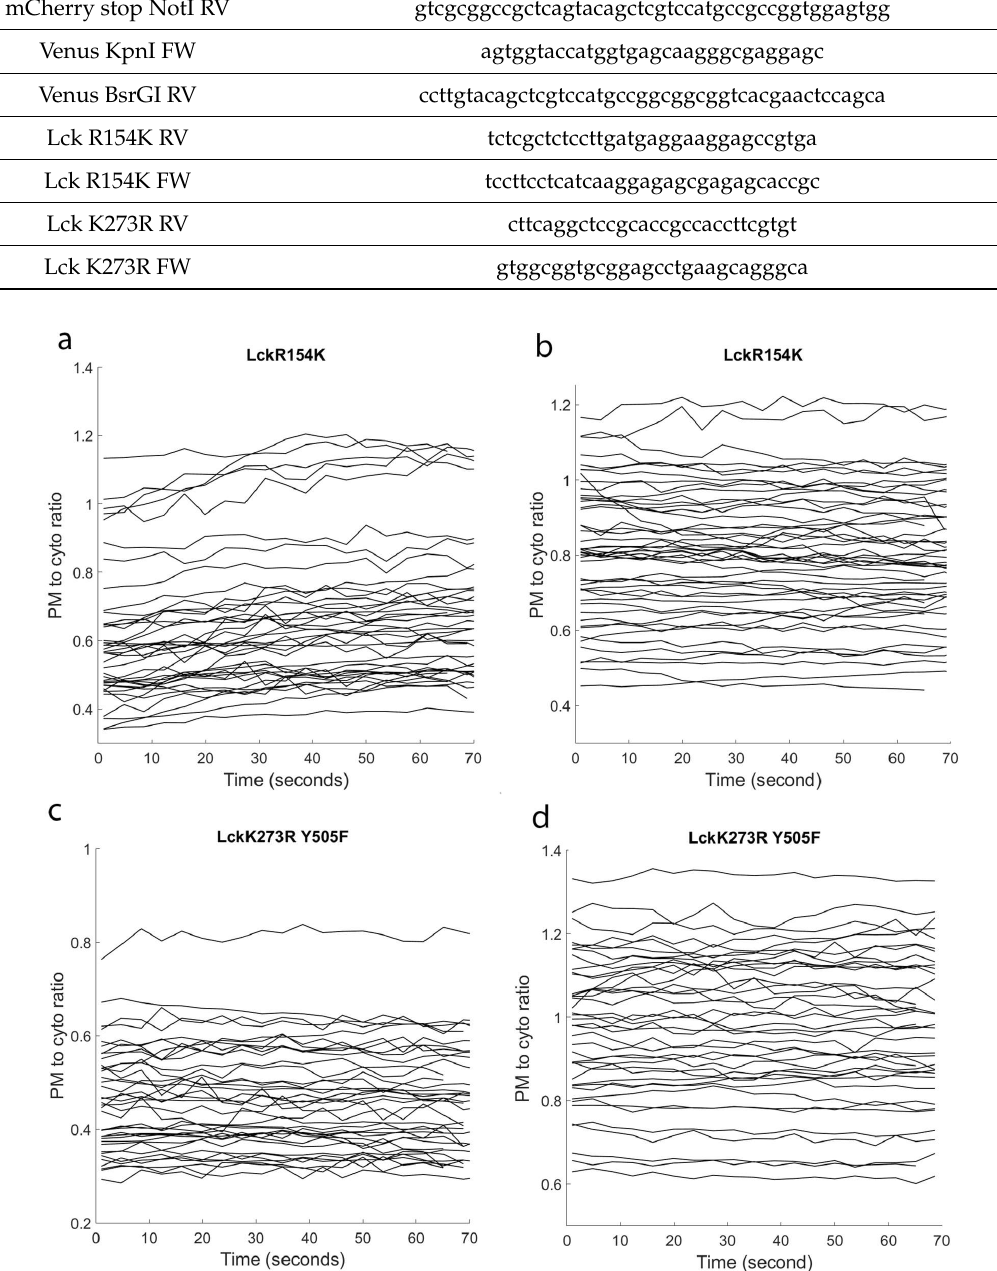
Figure A1. Plot of the cell plasma membrane to cytosol distribution ratio of Zap70 tSH2 (left) and LIC- Z-YFP (right) over time after light induced clustering of LIC-Z-YFP in cells co-transfected with LIC- Z-YFP, Zap70 tSH2 and the indicated Lck mutant, including SH2 domain binding mutant (Lck R154K)